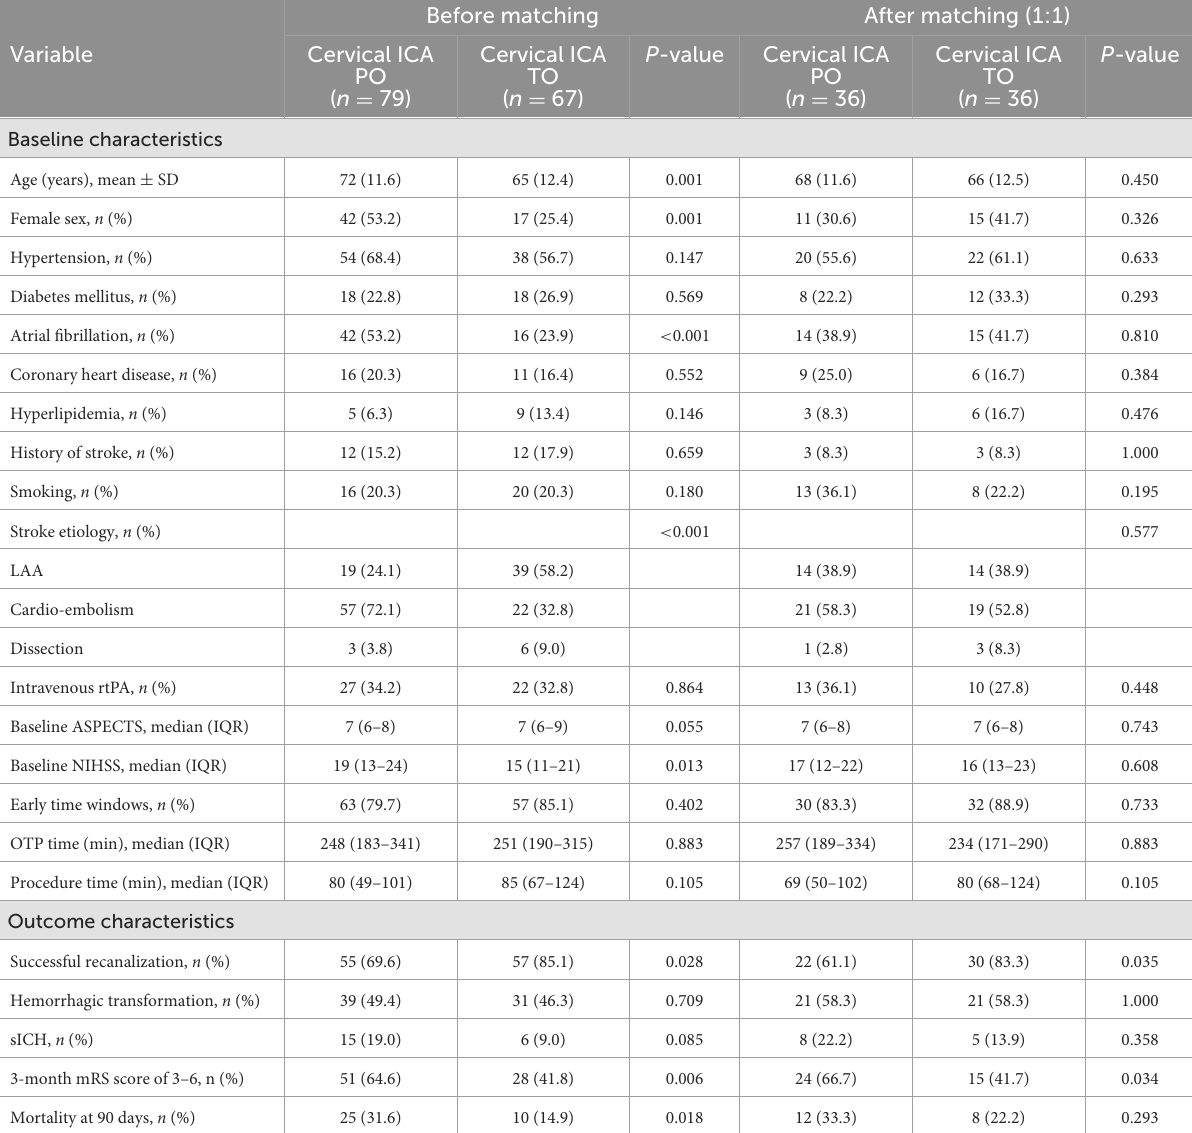
TABLE 1 Comparison between the cervical ICA PO and TO groups using propensity score matching. Before